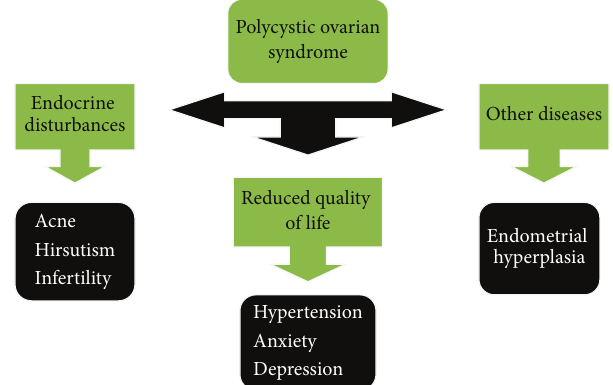
Figure 1: Flow chart showing possible consequences and outcomes of PCOS.